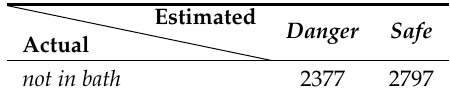
Table 2. Classification result of danger detection block for 5174 false positive detections in activity classification block.